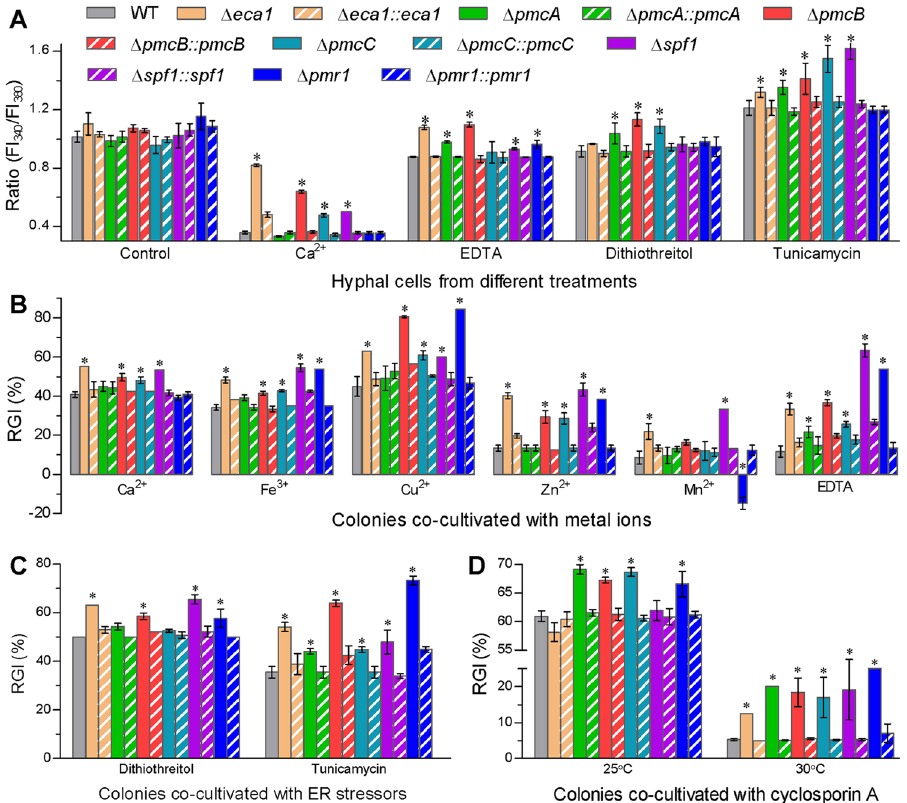
Figure 2. Roles for six CA pumps in sustaining intracellular Ca 2 + homeostasis and cellular responses to metal ions, and ER and calcineurin inhibitors in B . bassiana . ( A ) FI 340 /FI 380 ratios indicative of free Ca 2 + concentrations in the cells of CA deletion mutants and control strains stained with Fura-2-AM. ( B – D ) Relation growth inhibition of fungal colonies by metal ions [Ca 2 + (0.5 M), Fe 2 + (3 mM), Cu 2 + (2 mM), Zn 2 + (10 mM), Mn 2 + (5 mM) and the metal ion chelator EDTA (2 mM)], ER inhibitors [dithiothreitol (10 mM) and tunicamycin (5 µ g/ml)] and calcineurin inhibitor [cyclosporin A (25 ng/ml)] in minimal CZA, respectively. All colonies initiated with the spotting method were incubated for 8 days at 25 °C. The asterisked bars in each bar group differ significantly from those unmarked (Tukey’s HSD, P < 0.05). Error bars: SD from three cell samples ( A ) or replicates ( B – D